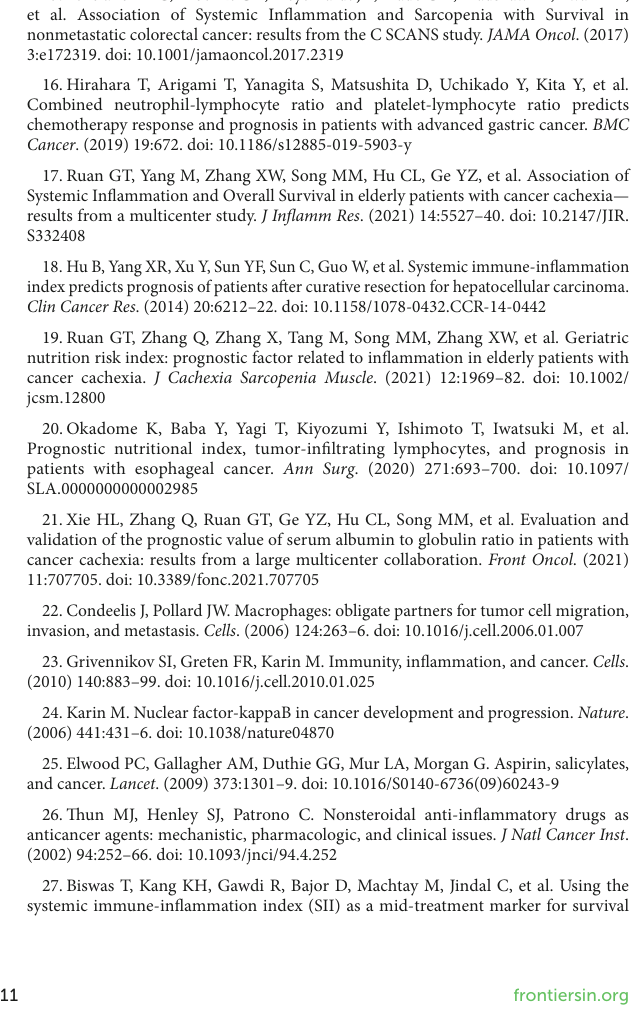
SUPPLEMENTARY FIGURE S2 The optimal cut-off value of GNRI based on the survminer R software package. SUPPLEMENTARY FIGURE S3 Pathway for patient recruitment and selection. SUPPLEMENTARY FIGURE S4 Significant negative correlation between SII and GNRI. SUPPLEMENTARY FIGURE S5 Survival prediction of SII in different subgroups. SUPPLEMENTARY FIGURE S6 Survival prediction of GNRI in different